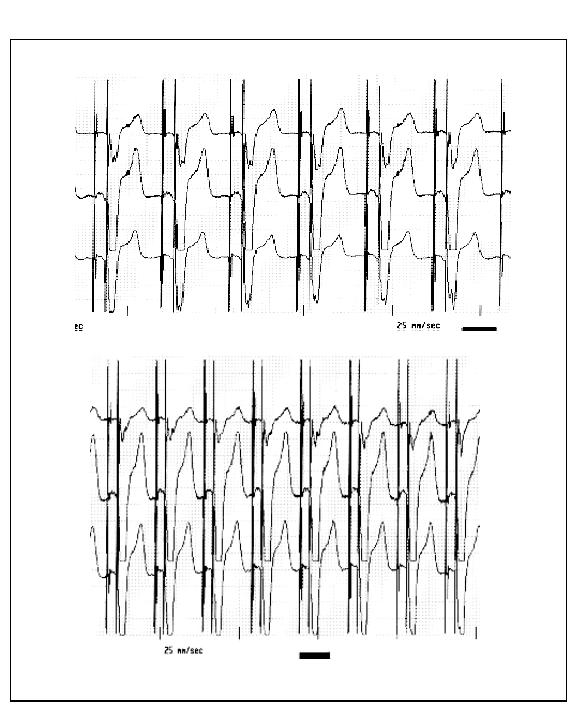
Fig. 4 – Exemplo da modificação de freqüência de estimulação ocorrido diante de estresse